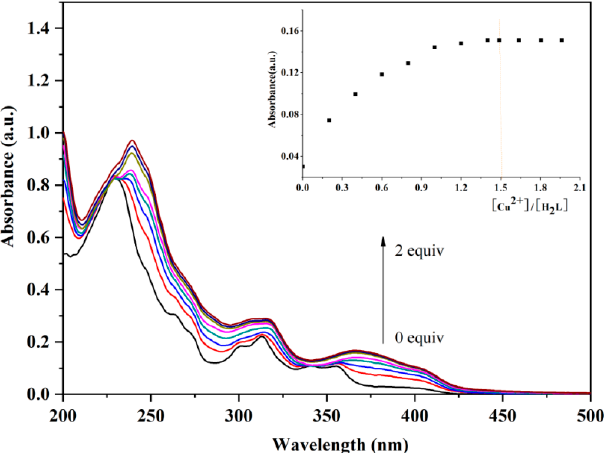
Figure 1. UV-Vis spectra of H 2 L and its Cu II complex.